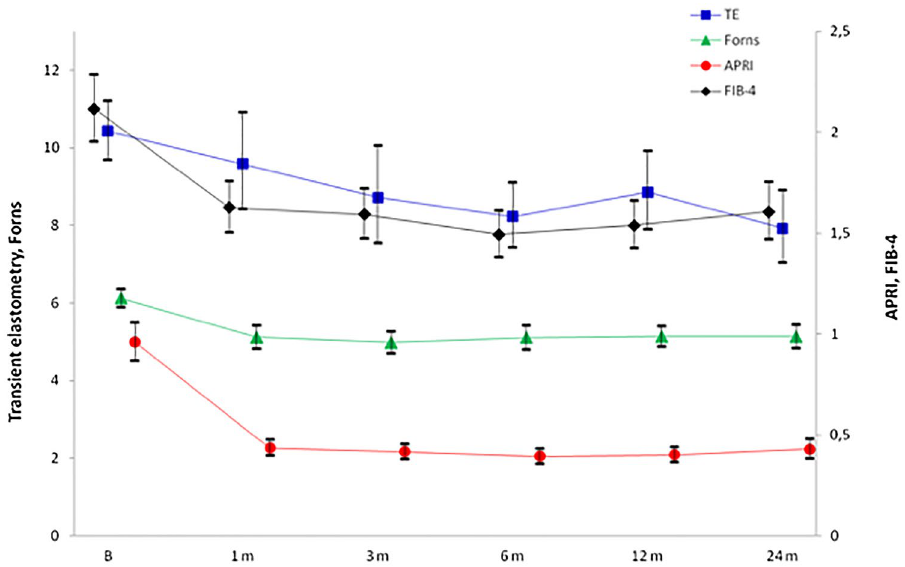
Figure 1. Course of the transient elastometry, APRI, Forns and FIB-4 indexes over time (mean, 95%